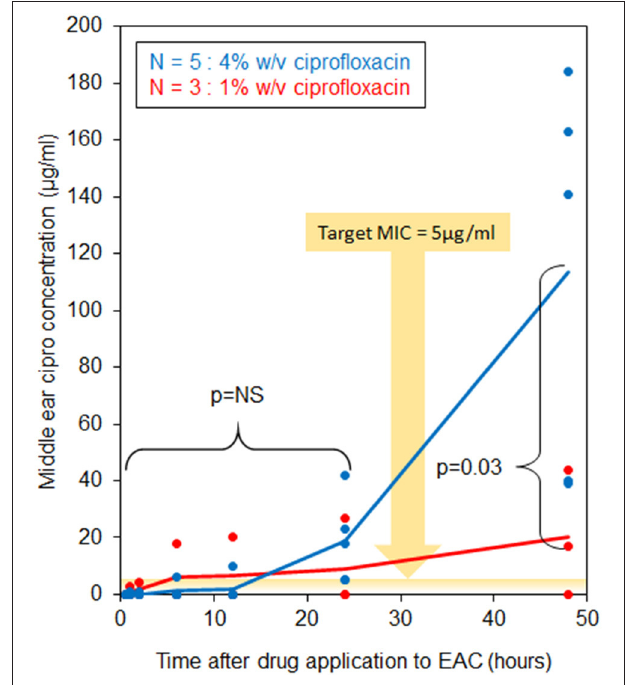
FIGURE 5 | Middle ear ciprofloxacin concentration over